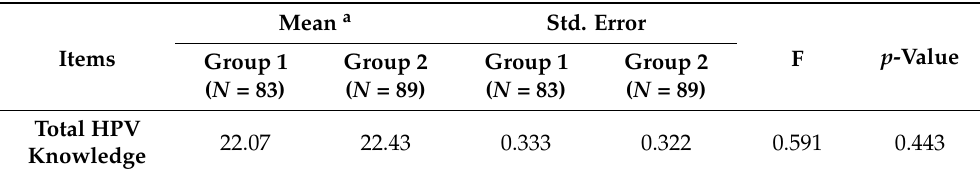
Table 7. ANCOVA Comparison of total HPV knowledge after the intervention between the two groups with adjustment for the baseline